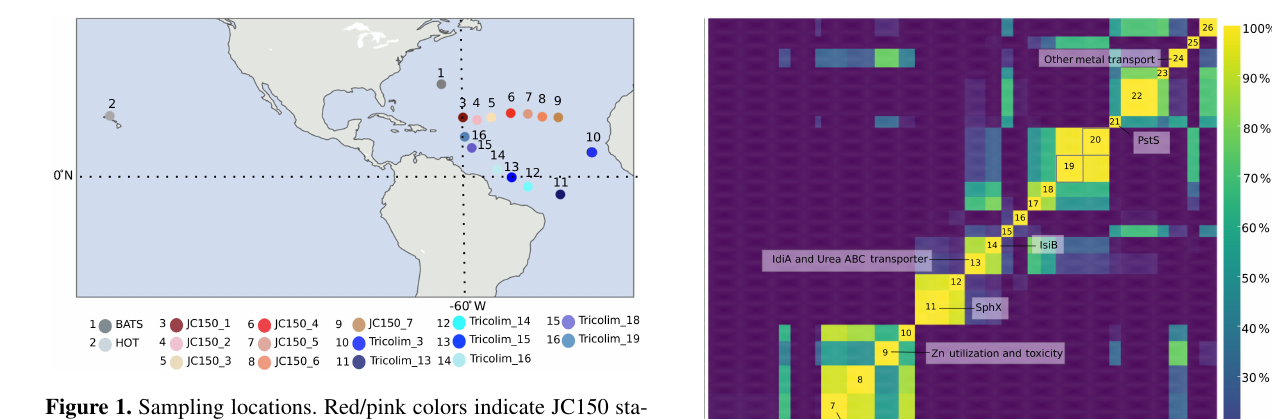
Figure 1. Sampling locations. Red/pink colors indicate JC150 sta- tions, blue colors indicate Tricolim stations, dark gray indicates the Bermuda Atlantic Time-series Study (BATS), and light gray indi- cates Hawaii Ocean Time-series (HOT). Most samples exist in du- plicate or triplicate; see Table S2 for detailed information.